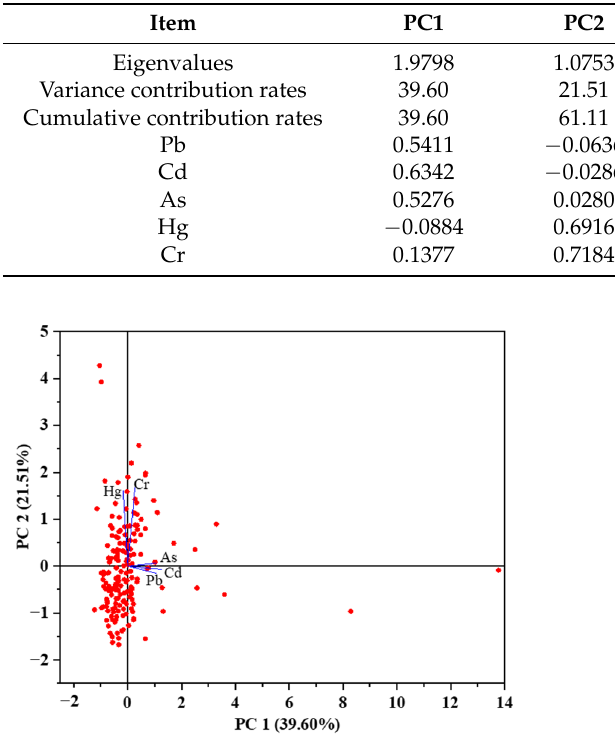
Figure 10. Principal component score plots of five heavy metals. Table 6. Eigenvalues, variance contribution rates, cumulative contribution rates, and component matrix of the principal components of heavy